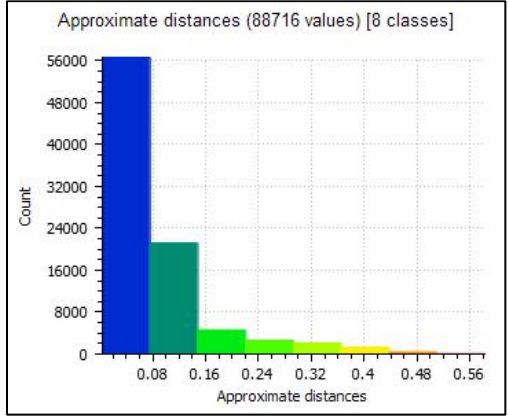
Figure 14: Discrepancy histogram between the UAV Photoscan processing and UAV VisualSfM